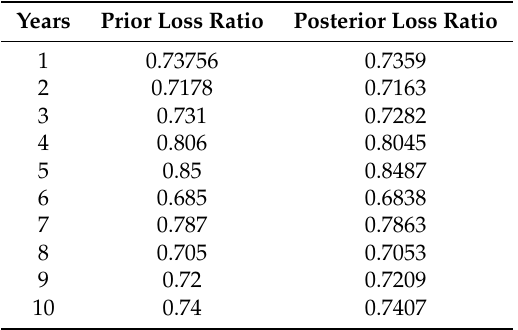
Table A4. Comparison between loss ratio a priori and posterior